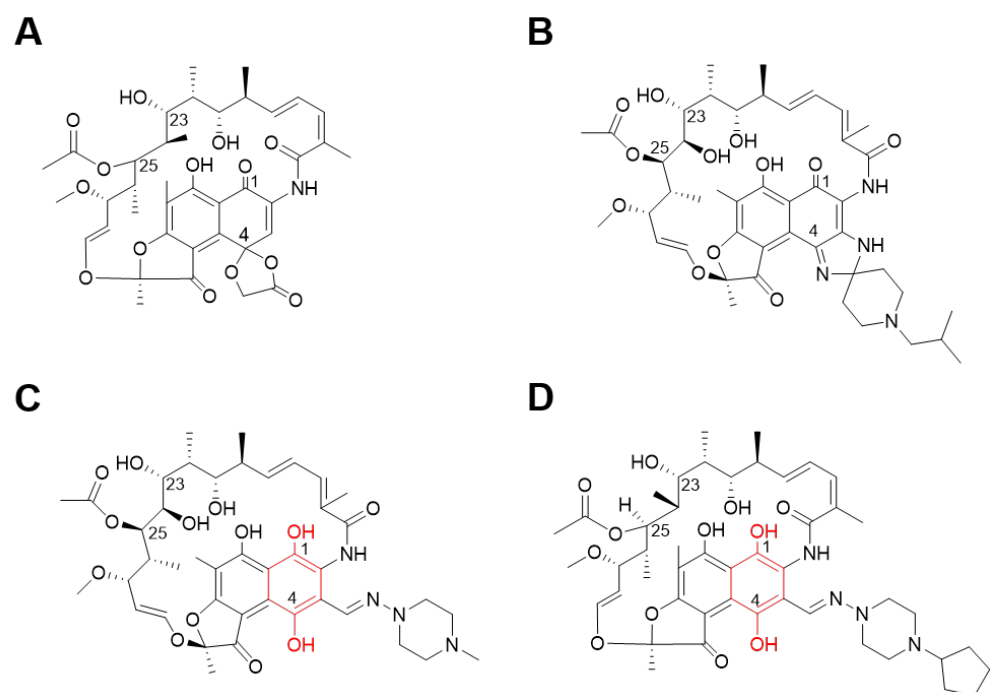
Figure 2. Chemical structures of rifamycin analogs . Rifamycin O ( A ), rifabutin ( B ), rifampicin ( C ), and rifapentine ( D ). Red indicates hydroquinone.